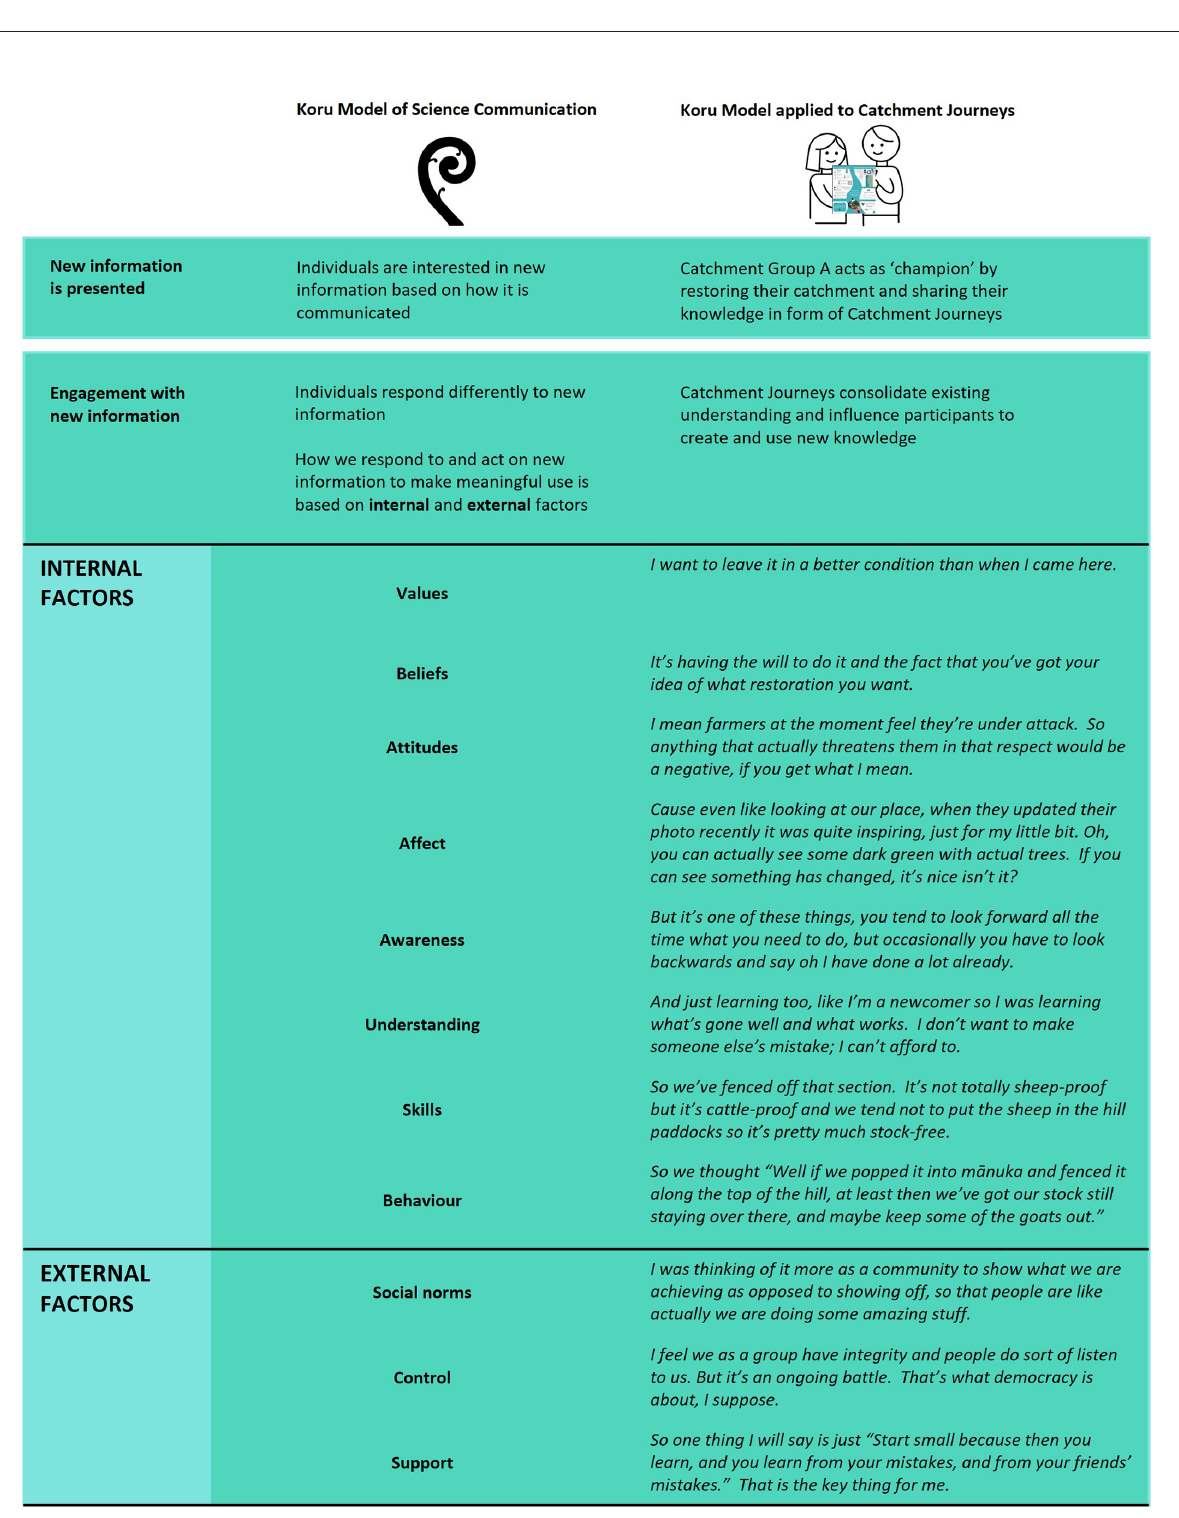
FIGURE2 Examples in focus group discussions that illustrate internal and external factors in the Koru Model of Science Communication that impact engagement with communicated